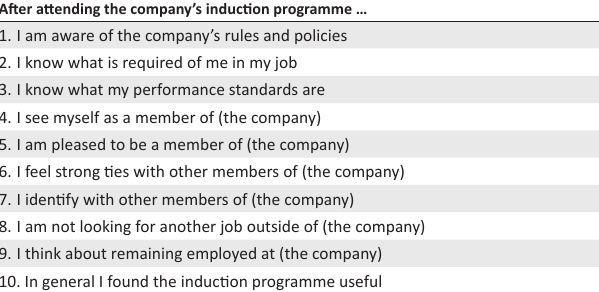
TABLE 1: Induction programme